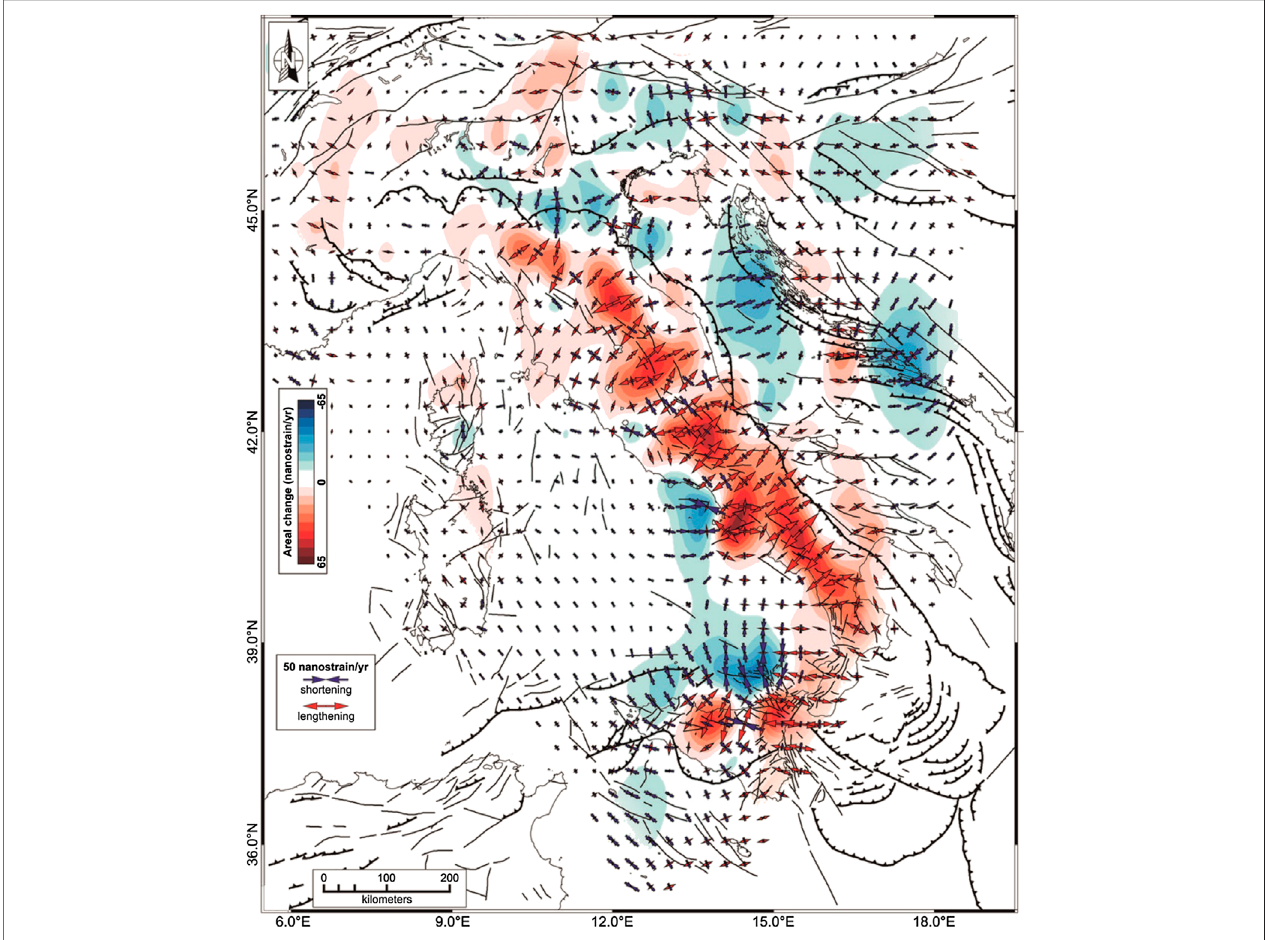
FIGURE 5 | Map of geodetic horizontal strain rate in Italy reproduced from Palano (2015). The color in background shows the rate of areal change, the arrows represent the greatest extensional (red) and contractional (blue) horizontal strain rates.